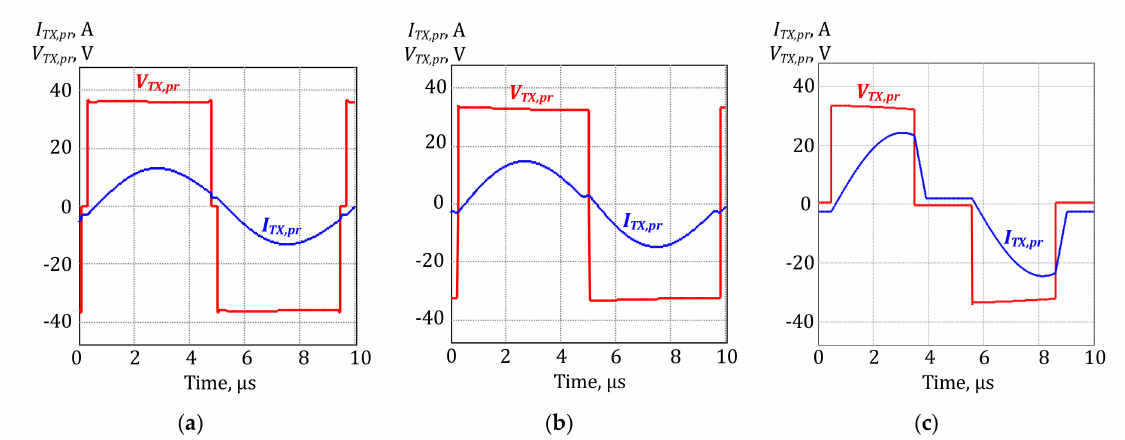
Figure 5. Simulated primary voltage and current waveforms of three key study isolation transformers at V PV = 33 V and operating power of 300 W: ( a ) the boost mode with D ST = 0.03 for TX1 with n 1 = 5.7, ( b ) the DCX mode for the baseline transformer TX with n = 6.1, and ( c ) the buck mode with ϕ = 73.8 ◦ for TX2 with n 2 = 6.7.